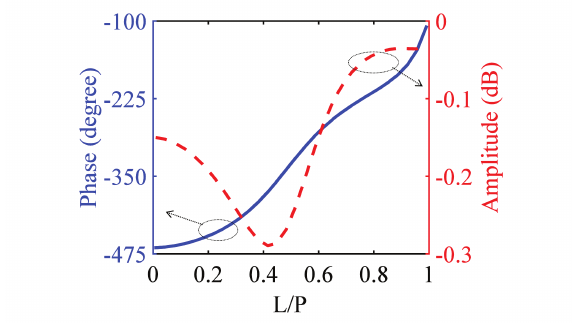
Figure 3: Reflection coefficient of the unit cell as a function of hole diameter at 10 GHz.